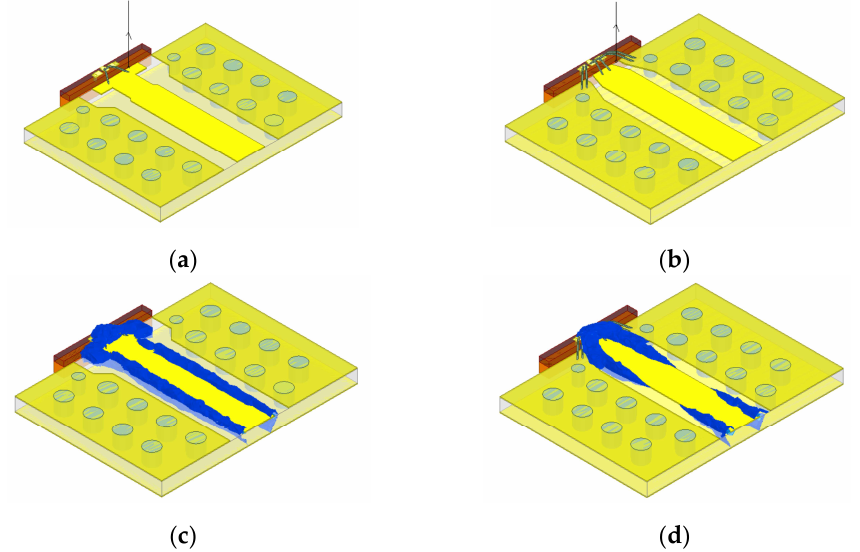
Figure 15. ( a ) Matching compensation bonding wire structure model. ( b ) GSG bonding wire structure model. ( c ) Electric field of matching compensation bonding wire structure. ( d ) Electric field of GSG bonding wire structure.